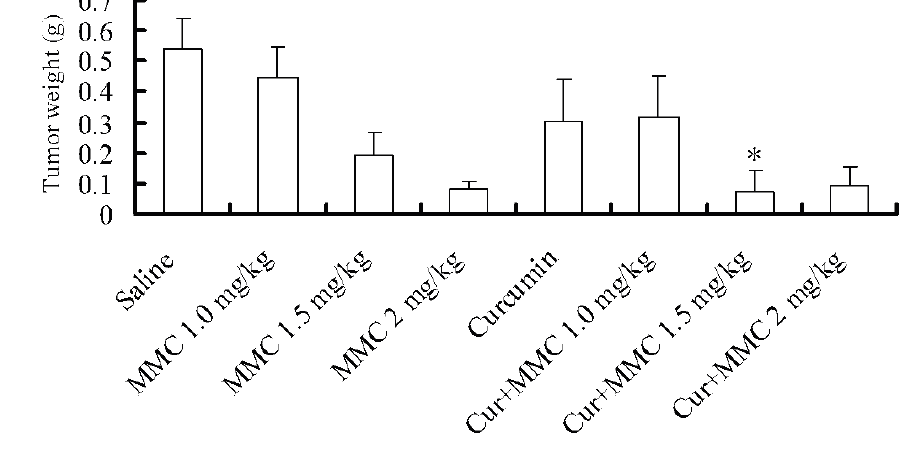
Figure 1. Effect of mitomycin C (MMC) or MMC combined with curcumin on tumor outgrowth in MCF-7 xenografts. Mice were first injected with MCF-7 cells for two weeks to establish xenograft. Mice were then administrated with MMC at the doses of 1.0, 1.5 and 2 mg/kg with or without curcumin. After four weeks treatments, the mice were sacrificed, and tumors were excised and weighed. * p < 0.05 versus 2 mg/kg MMC